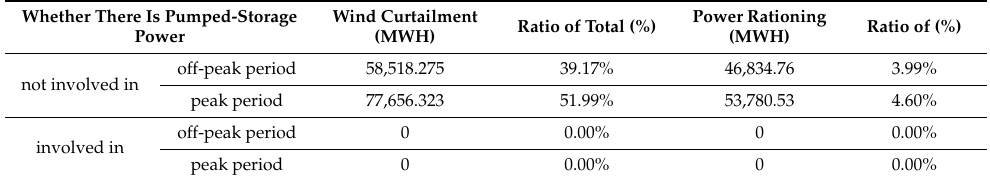
Table 4. Quantitative